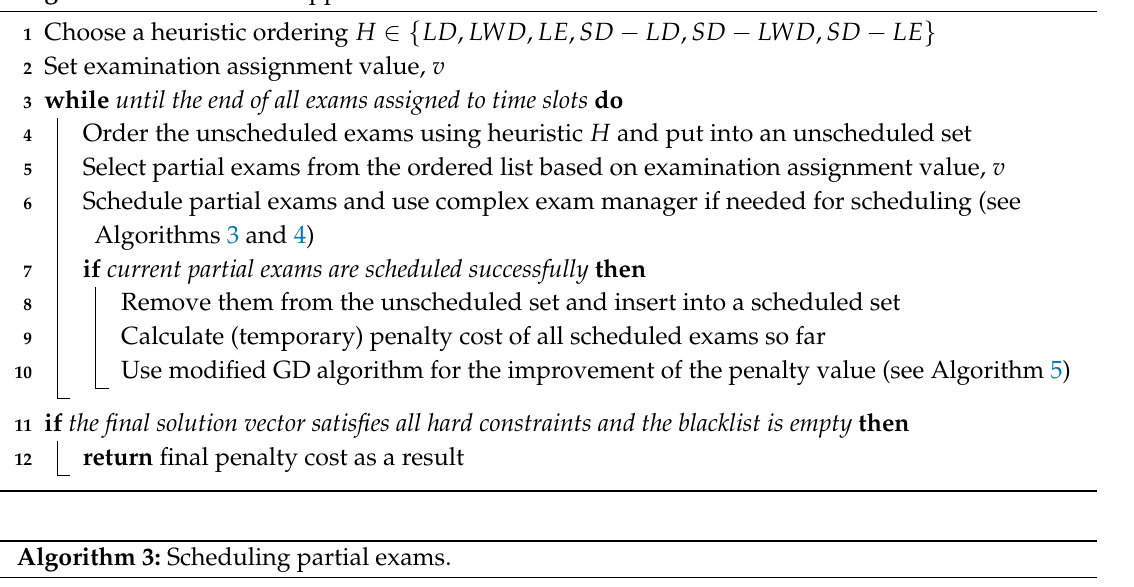
Algorithm 2: PGH-mGD approach.